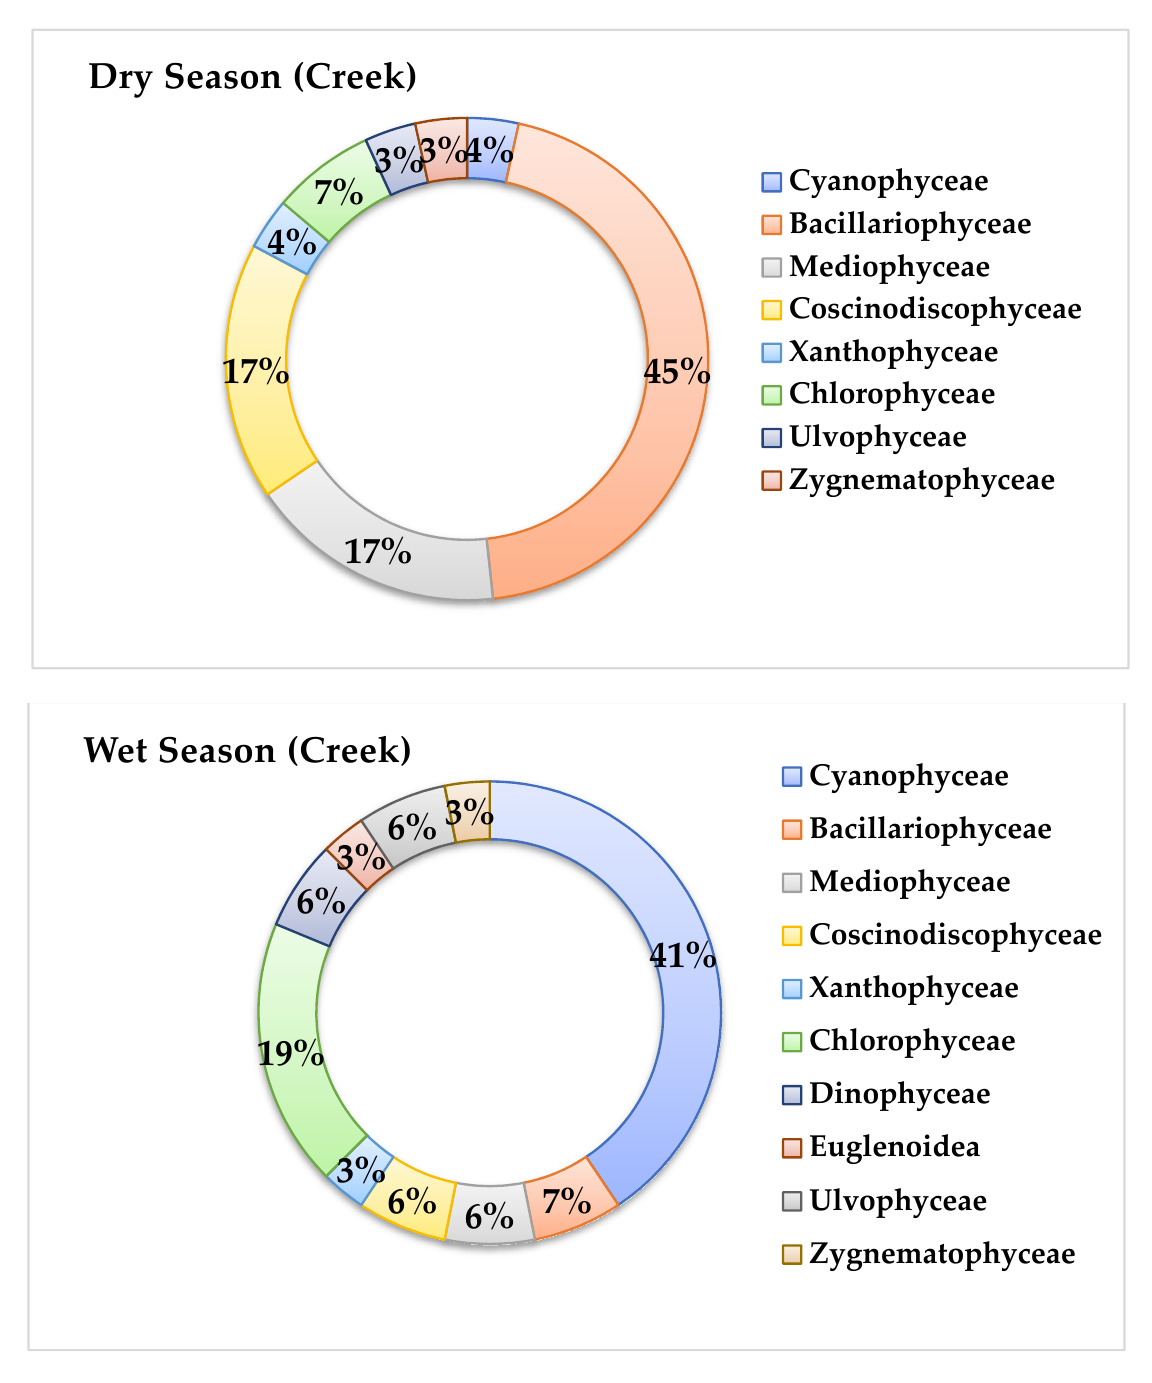
Figure 4. Percentage composition of phytoplankton during the dry and wet seasons in the mangrove creeks.